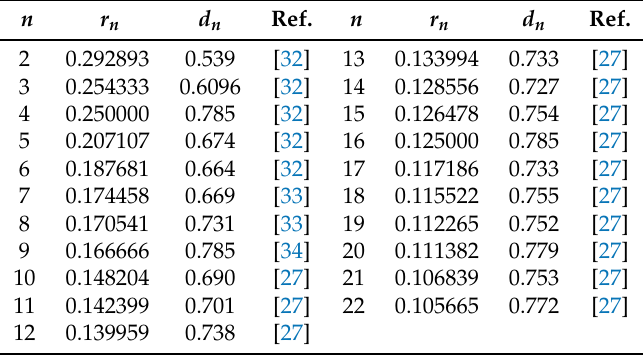
Table 1. Results of packing of n equal circles in a unit